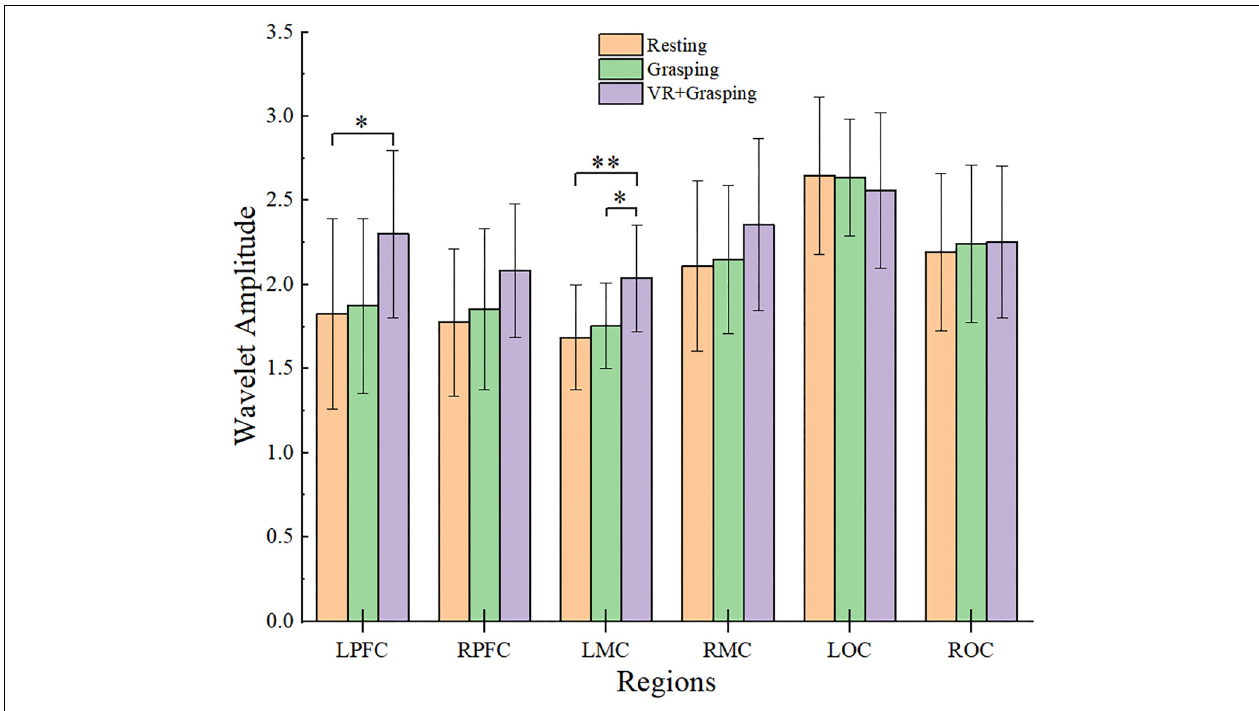
FIGURE 6 | Amplitude changes of brain regions in different states and the comparison results, ∗ were used to mark significant differences, among which ∗ ( p < 0.0167), ∗∗ ( p < 0.001). The yellow column represents the resting state, the green column represents the grasping movements, and the purple column represents the VR grasping